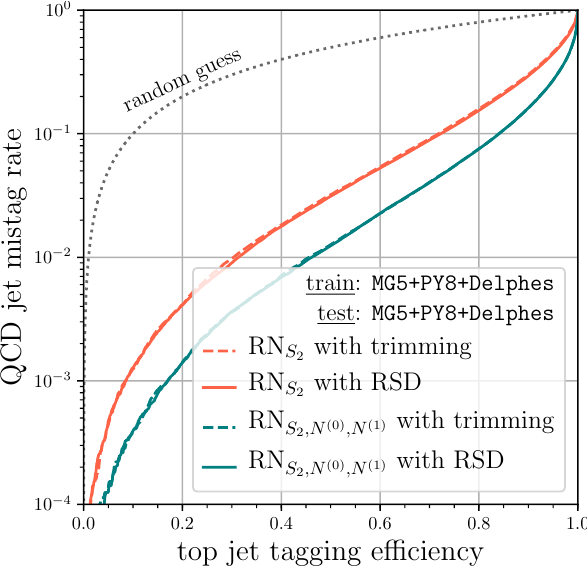
Figure 15. The ROC curves of RN S